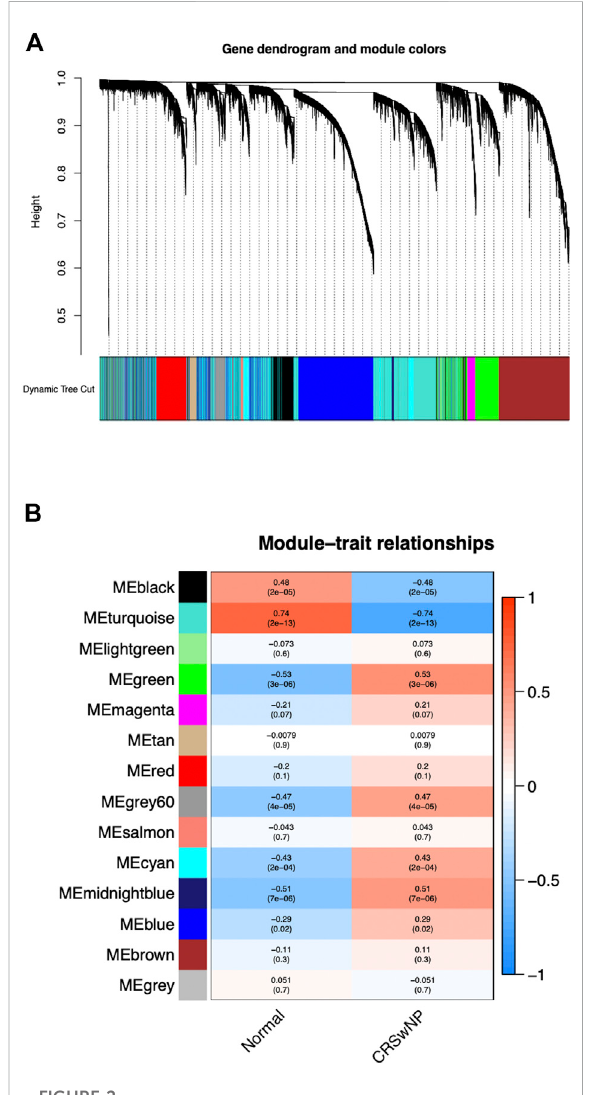
FIGURE 2 Theconstructedgeneco-expressionmodulesofCRSwNPby WGCNA in R. (A) Gene-module tree diagram. Each branch represents one gene, and every color below represents one co- expression module. (B) Module-trait relationship diagram. 14 modules were generated; the MEgreen (RS = 0.53, P = 3e-06) and MEturquoise (RS = − 0.74, P = 2e-13) modules were most signi fi cantly related to CRSwNP.